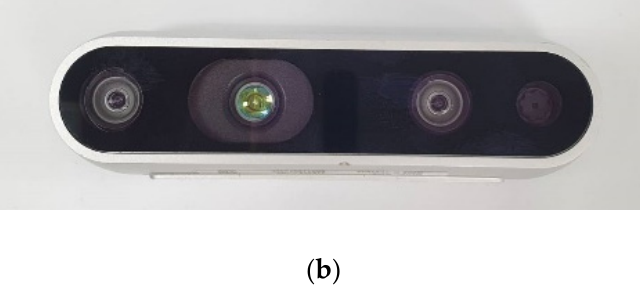
Figure 6. The sensors that are installed on the electric wheelchair: ( a ) SICK TIM551 2D-LiDAR and ( b ) Intel ® RealSense D435i RGB-D camera.